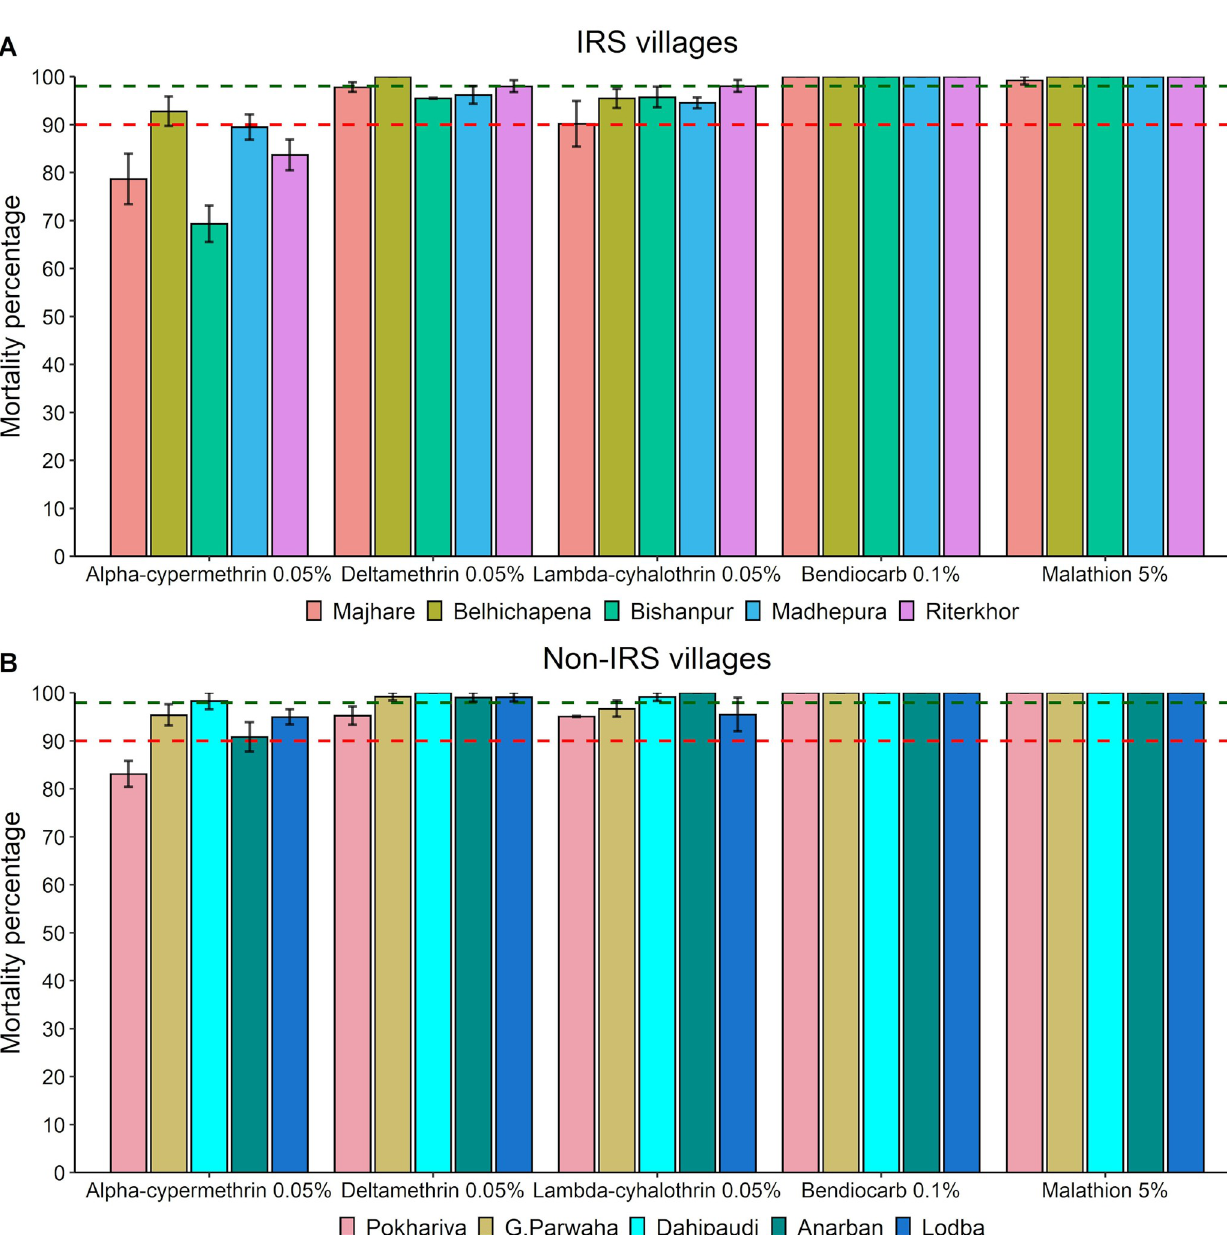
PLOS NeglectedTropical Diseases | https://doi.org/10.1371/journal.pntd.0010304 July 14,